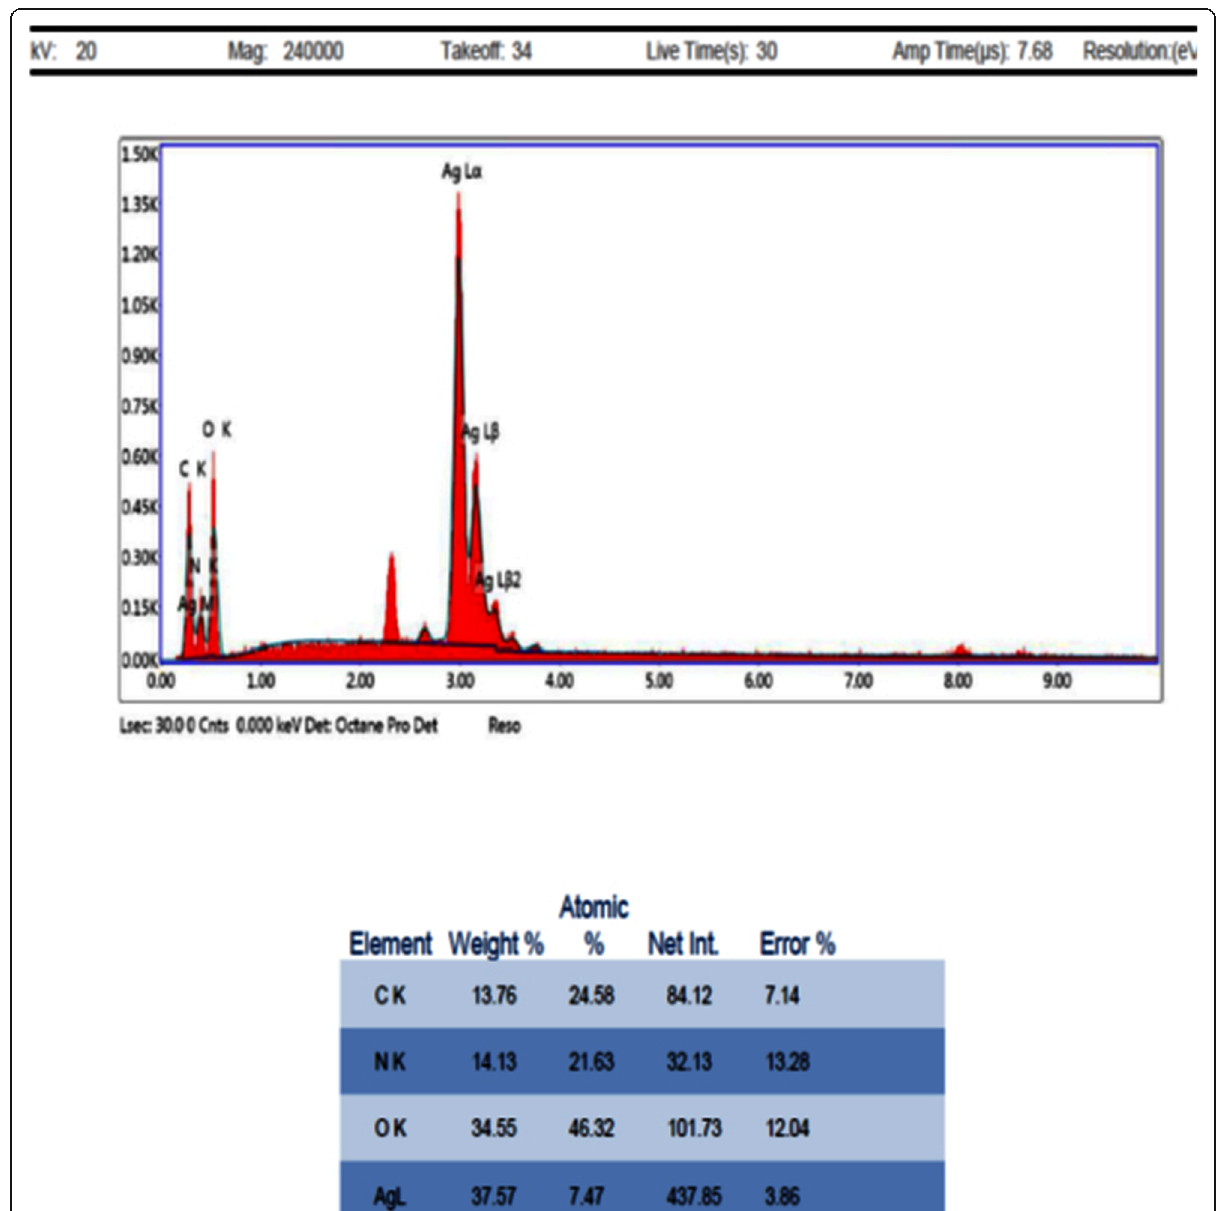
Fig. 6 EDAX micrograph of plantaricin-incorporated silver nanoparticles (PL-SNPs), C: carbon content, N: nitrogen content, O: oxygen content, Ag: silver